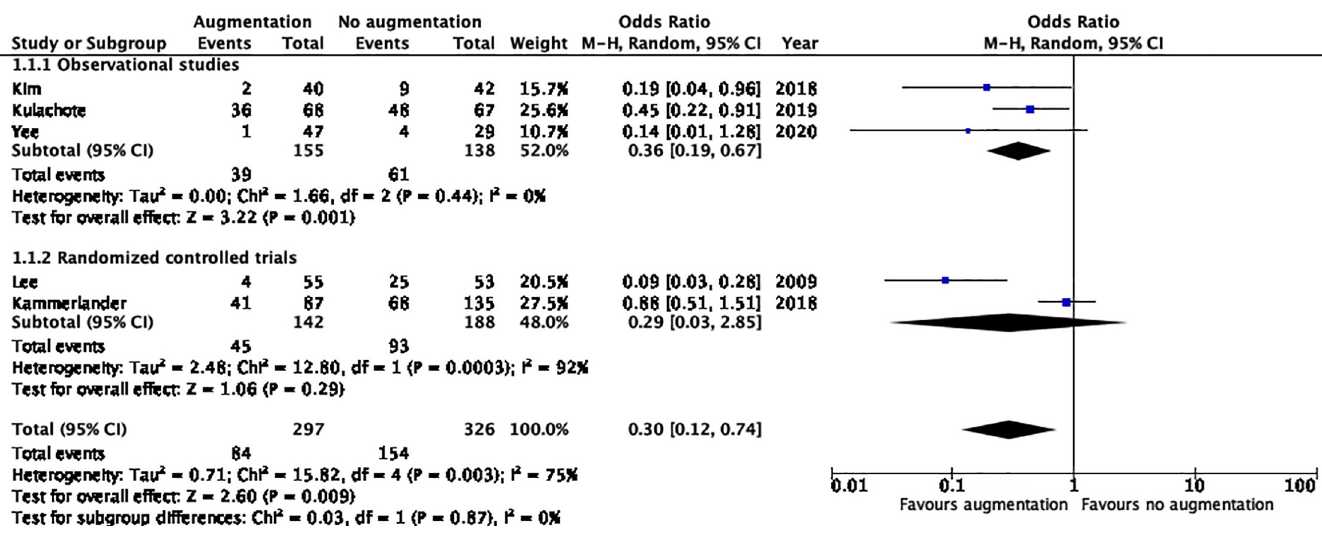
There was no difference in pooled risk estimates between randomized clinical trials and observational studies.